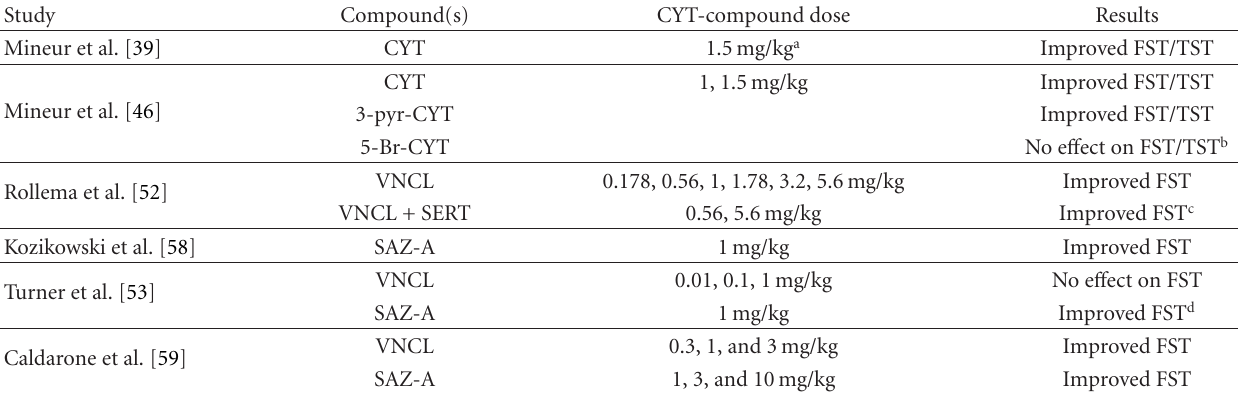
Table 2: Evidence for cytisine and cytisine-based compounds in mouse models of